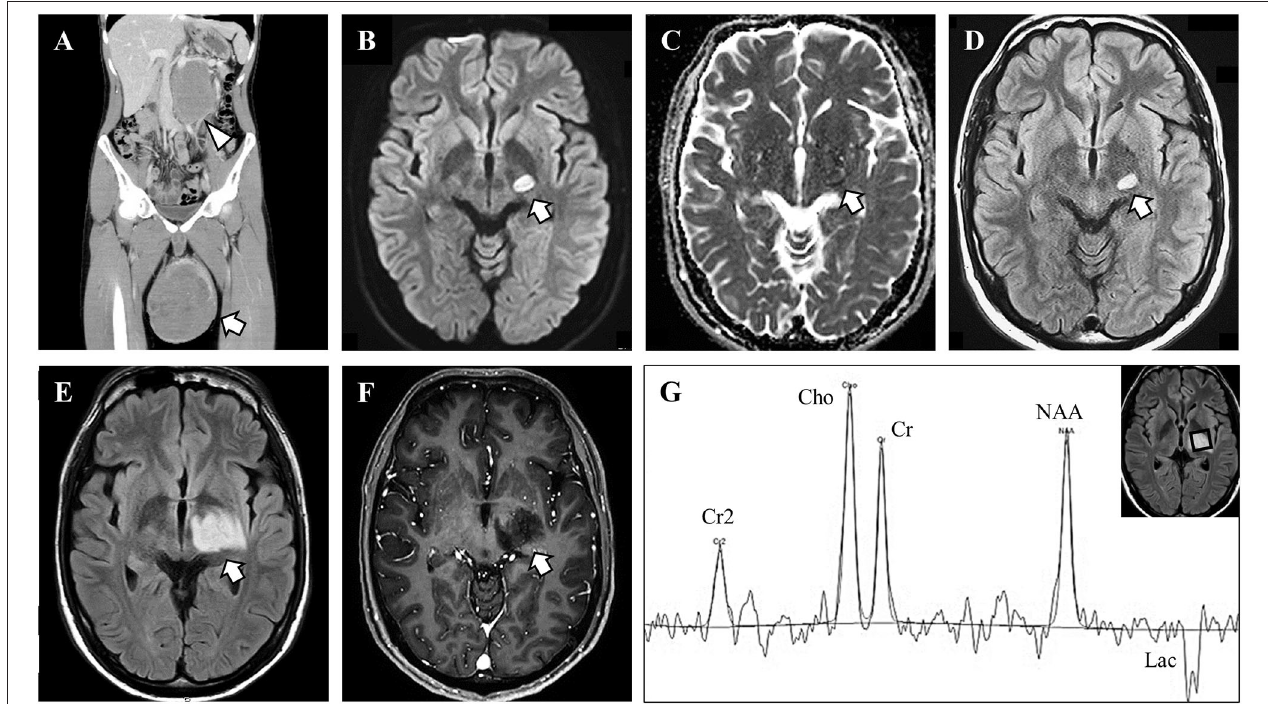
FIGURE 1 | Imaging and magnetic resonance spectroscopy findings. (A) Body trunk computed tomography showed enlargement of the left testicle with heterogeneous content (arrow) and retroperitoneal lymph node (arrowhead). (B–D) Brain magnetic resonance imaging (MRI) on admission showed a high-intensity lesion in diffusion-weighted and fluid-attenuated inversion recovery (FLAIR) images, with iso-intensity in apparent diffusion coherence images. (E, F) The brain lesion enlarged afterward, but with no gadolinium enhancement. (G) Magnetic resonance spectroscopy showed high choline (Cho) peak, preserved N-acetyl aspartate (NAA) peak, and lactate (Lac) peak. Cr,